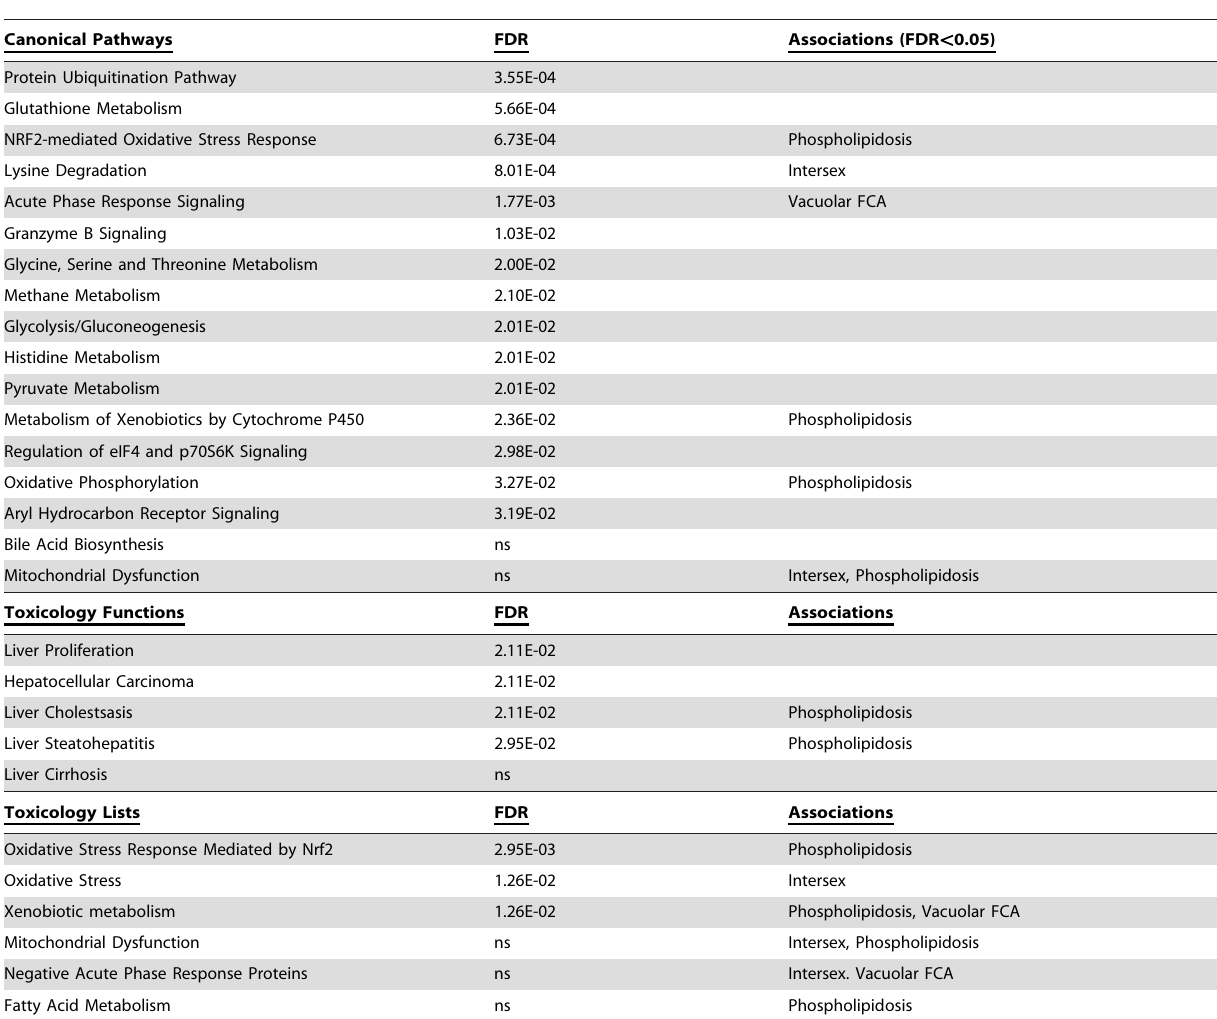
Table 3. Ingenuity annotations associated with site and histopathological